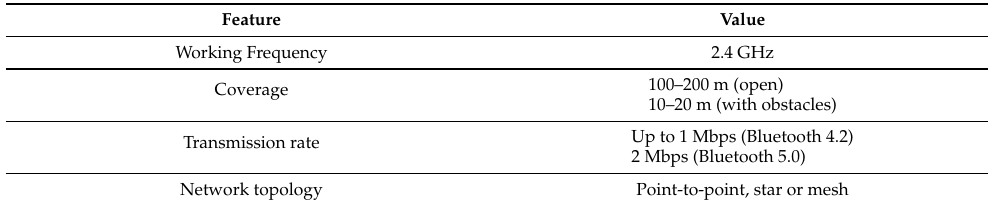
Table 2. Main characteristics of